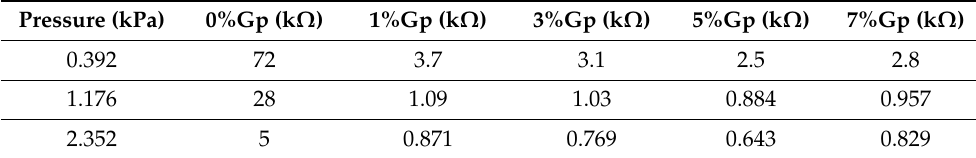
Table 1. Resistance values of different Gp doping ratios at different